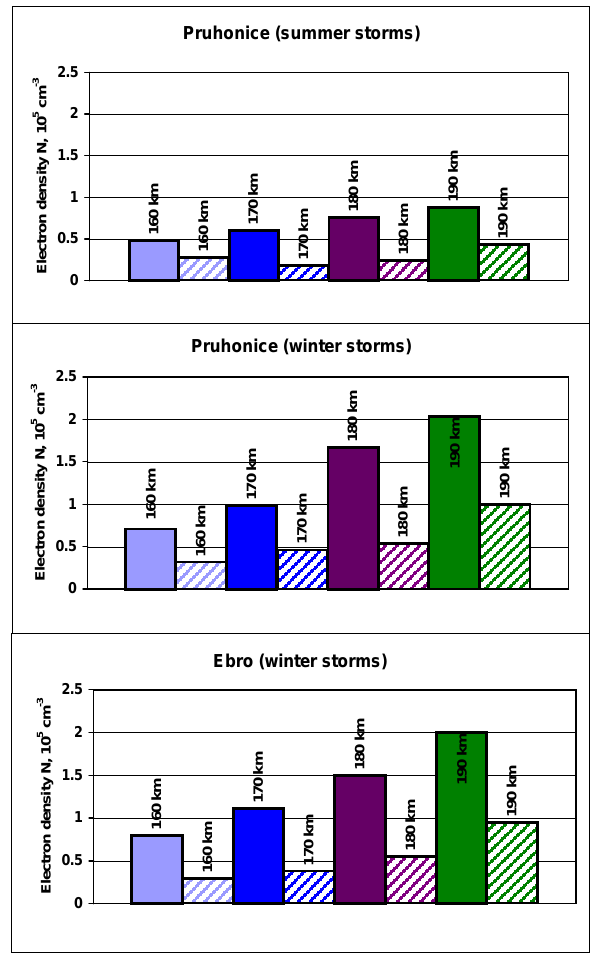
Fig. 10. The magnitude of the electron density decrease at the F1-region heights (the difference between the storm main phase and pre-storm quiet days at 11:00–13:00UT) for the super storm of July 2000 versus the May 1997 strong storm (analyzed by Bu- resova and Lastovicka, 2001) for Pruhonice (top panel), and for the super storm of March/April 2001 versus the strong storms of Jan- uary 1996, February 1998, March 1998 and November 1998 (mid- dle panel – Pruhonice; bottom panel – Ebro). Full columns – super storms; dashed columns – strong